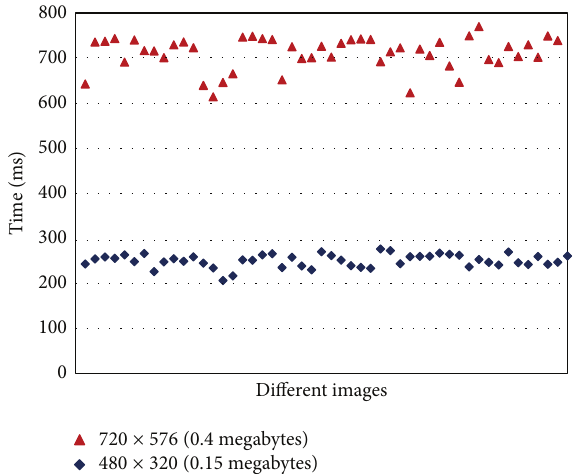
Figure 10: Computational time variability for fixed-size images for image enhancement in the tested smart tablet.